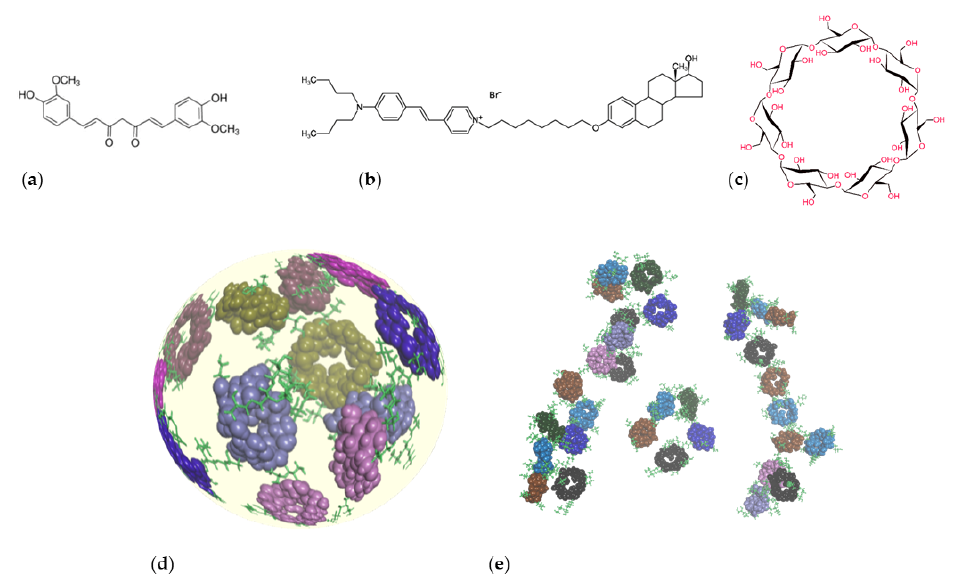
Figure 1. Chemical structures of curcumin ( a ), estradiol-glow ( b ), native β -cyclodextrin ( β CD) ( c ), Cyclodextrin microbeads β CDPB ( d ) and β -cyclodextrin polymer of irregular shape β CDPIS ( e ).